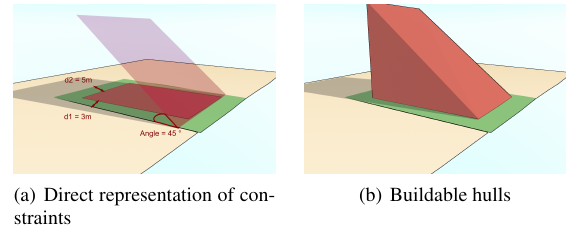
(a) Direct representation of con- straints Figure 4. Two possible information to indicate the constraints of the regulation.